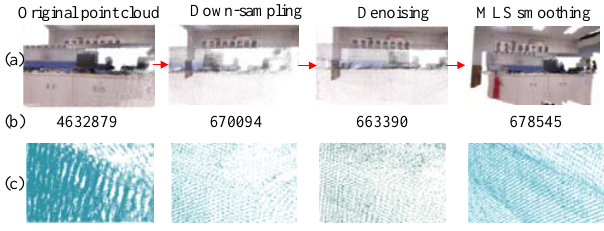
Figure 2. Point cloud data pre-processing. (a) Original Point cloud. (b) Points number. (c) Close look of the point